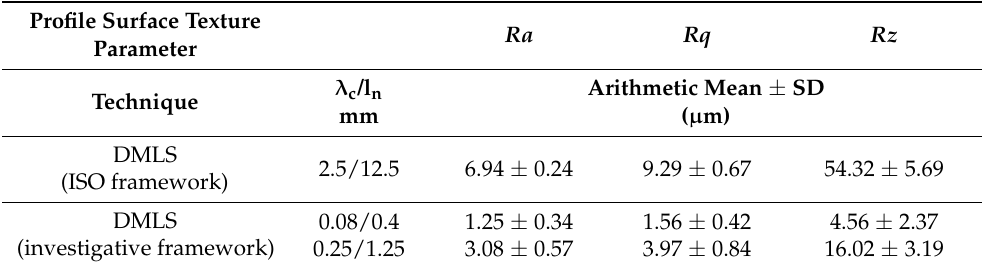
Table 6. Comparison of profile surface texture parameters from ISO and investigative framework.